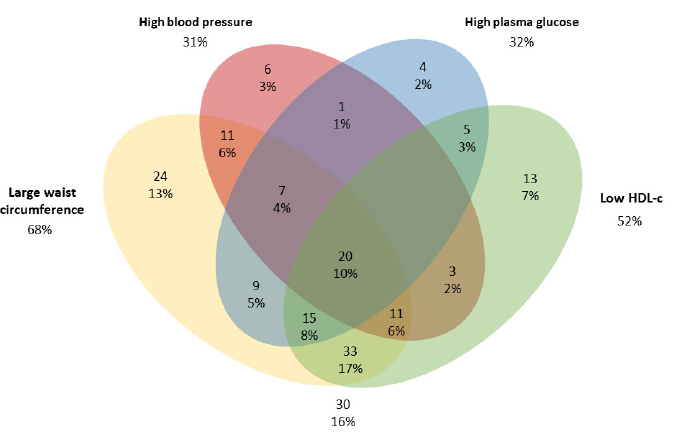
Figure 1. Venn diagram of components of the metabolic syndrome (MetS) in adults from a population- based study in urban Brazil ( n = 192). The cut-offs were: large waist circumference ( ≥ 80 cm for women or ≥ 90 cm for men); Low HDL-c (<50 mg/dL for women or <40 mg/dL for men); high blood pressure (systolic pressure ≥ 130 and diastolic pressure ≥ 85 mmHg) and High plasma glucose ≥ 100 mg/dL [1].